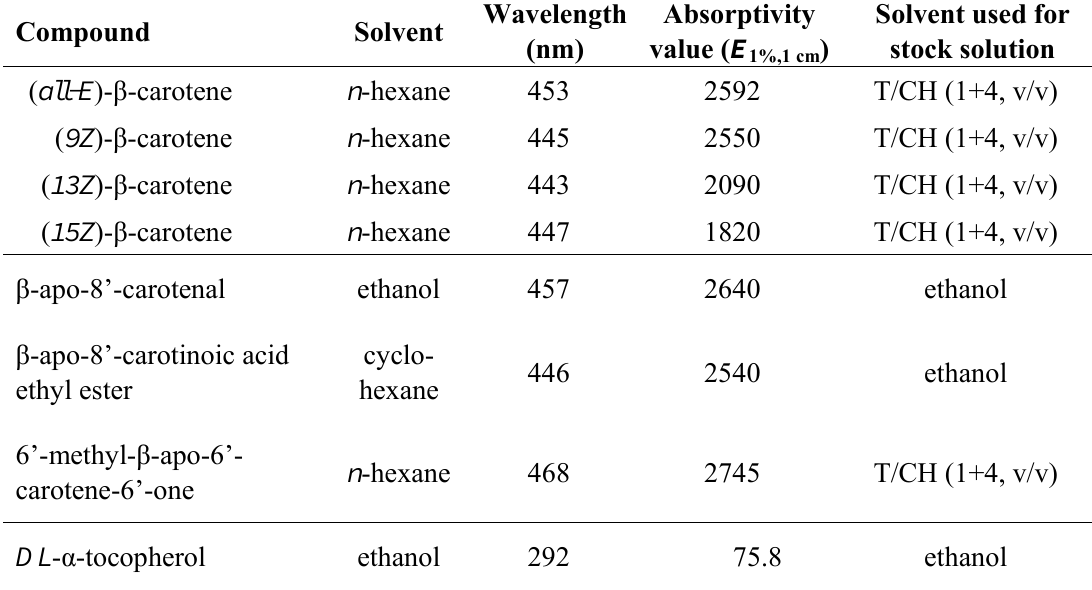
Table 2. Absorptivity values at specific wavelength maxima in specific solvent, and solvent used for stock solutions of analyzed β -carotene isomers and metabolites and α - tocopherol